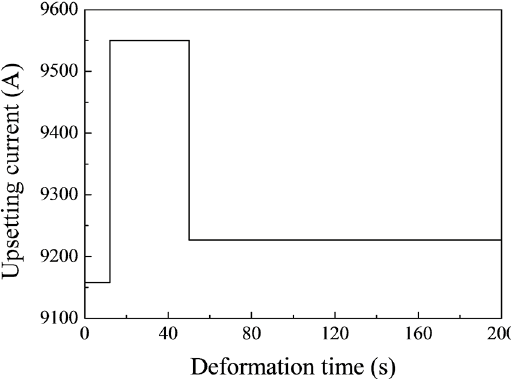
Figure 11: The three-stage current mode for electric upsetting of 3Cr20Ni10W2 heat-resistant alloy.